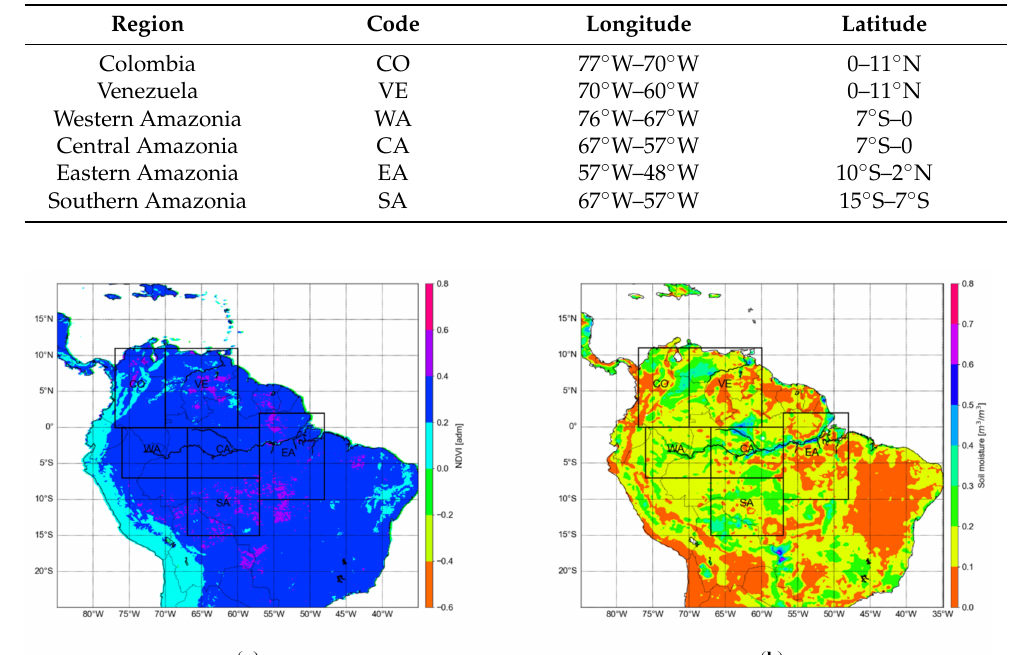
Table 1. Location of the regions of tropical South America included in the present study.